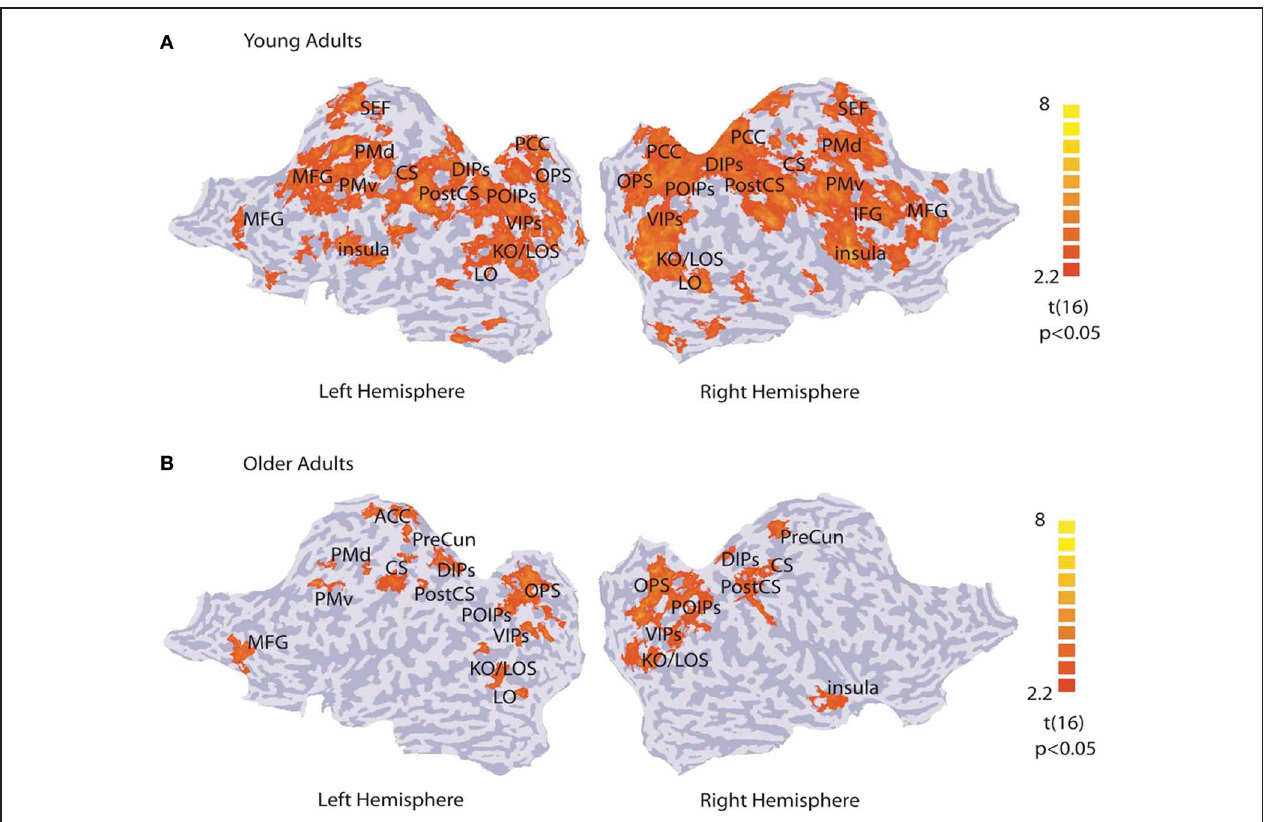
observers and sessions). Data are superimposed on flattened cortical surfaces of both hemispheres. Sulci are shown in dark gray, and gyri in light gray ( Table S1 for ROI definition and Talairach